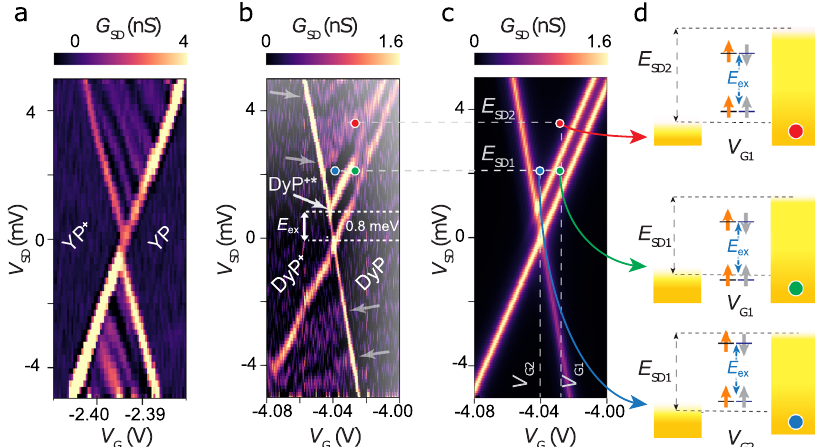
Fig. 3 Single-molecule transport measurements. a Map of the differential conductance G SD ¼ ∂ I SD = ∂ V SD , vs. V G and V SD for YP , at 20 mK, at B = 0. Coulomb diamonds are labeled with molecular states. b G SD map of the DyP + /DyP transition at B = 0 and 20 mK. Gray arrows indicate interference from graphene leads. The excited spin state, DyP + * is visible (white arrow) and marks indicate representative transport regions. c Simulation of the differential conductance map for the DyP + /DyP transition. Marks indicate representative transport regions. d Transport channels are available in the different regions, with the molecular energy levels depicted between the electrode energies (yellow). Arrows indicate the ferro- and antiferromagnetic arrangements of the Dy (orange) and fl owing electron spin (gray).